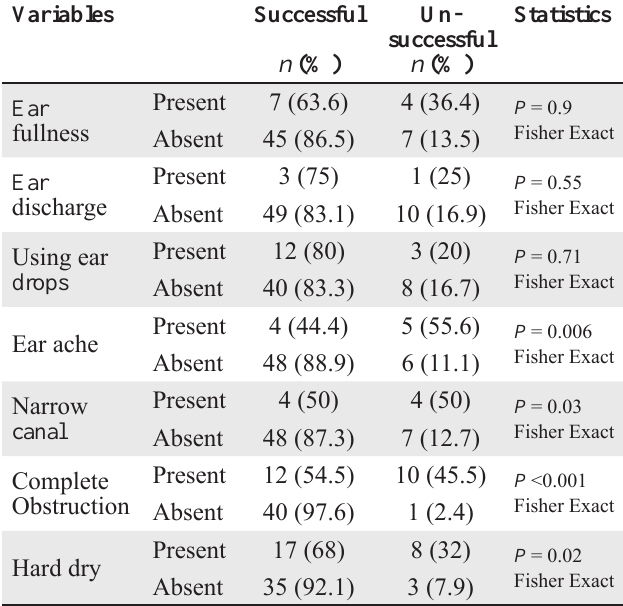
Table 1 : Relationship between outcome (successful or unsuccess- ful) and various factors. (N = 63)